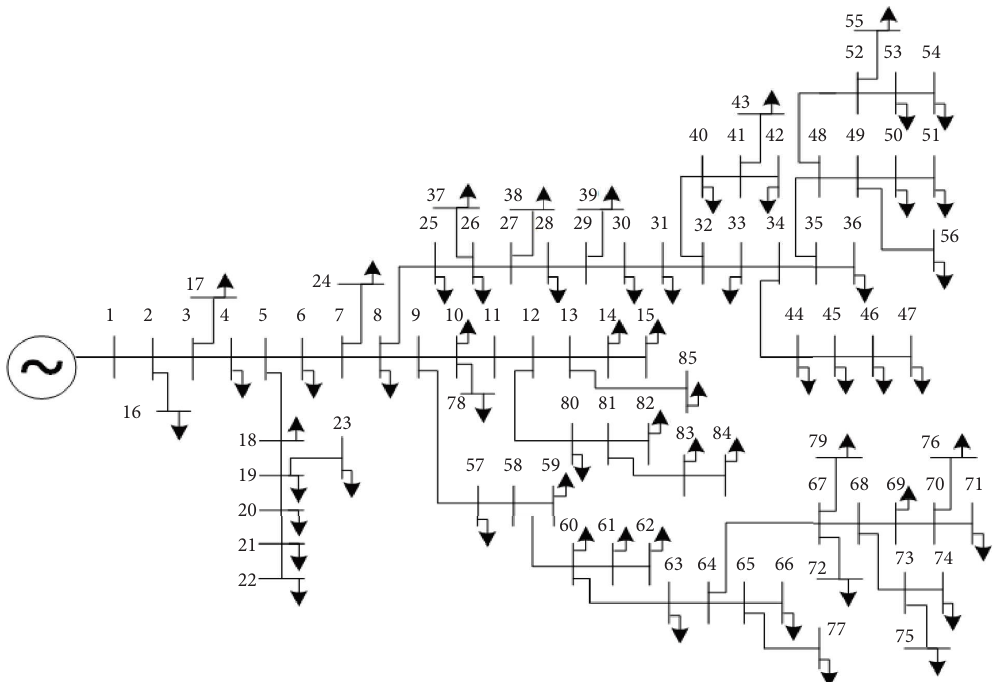
Figure 16: Te IEEE 85-bus radial distribution system.